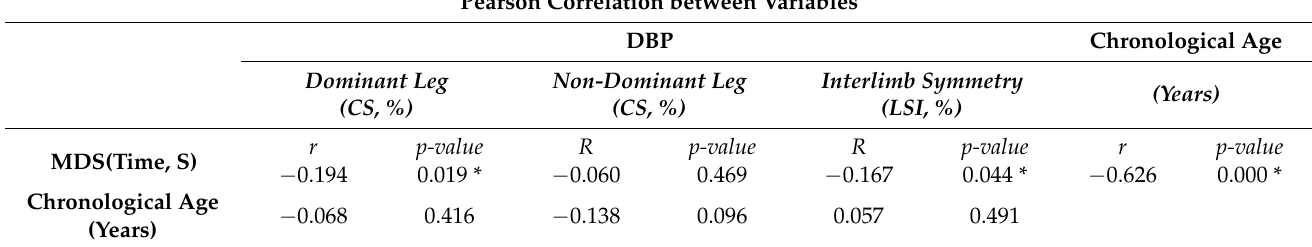
Table 3. Association analysis.